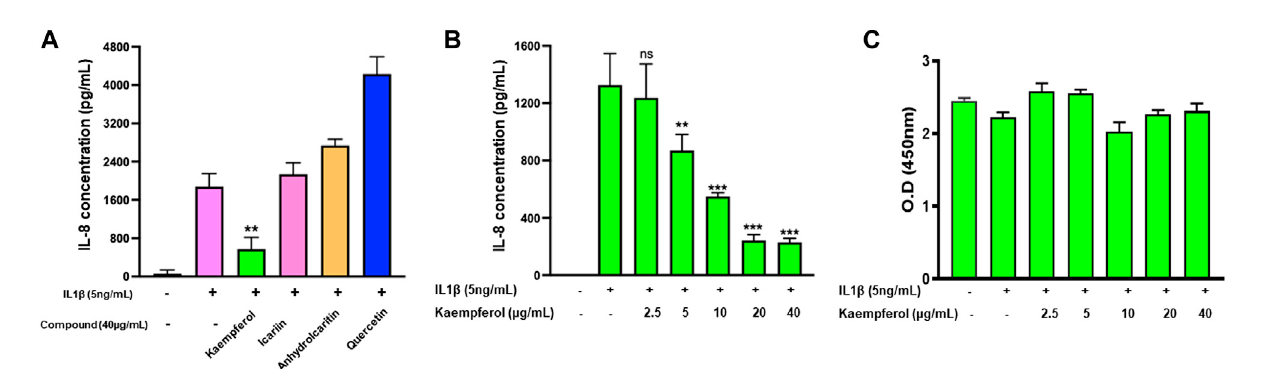
FIGURE 5 Effect of four epimedium candidate compounds on IL-8 production: HepG2 cells were cultured in presence of four main Epimedium candidate compound for 48 h. After whichcells werestimulated with IL-1 β (5 ng/m1). The supernatant were harvest and IL-8 levels were measured by ELISA. (A) Out of four main candidates, Kaempferol signi fi cantly reduced IL-8 levels. (B) Kaempferol showed a dose dependent inhibition of IL-8 production by stimulated HepG2 cells. (C) No cell cytotoxicity was observed with Kaempferol at different doses. Data represents triplicate experiments and expressed as mean